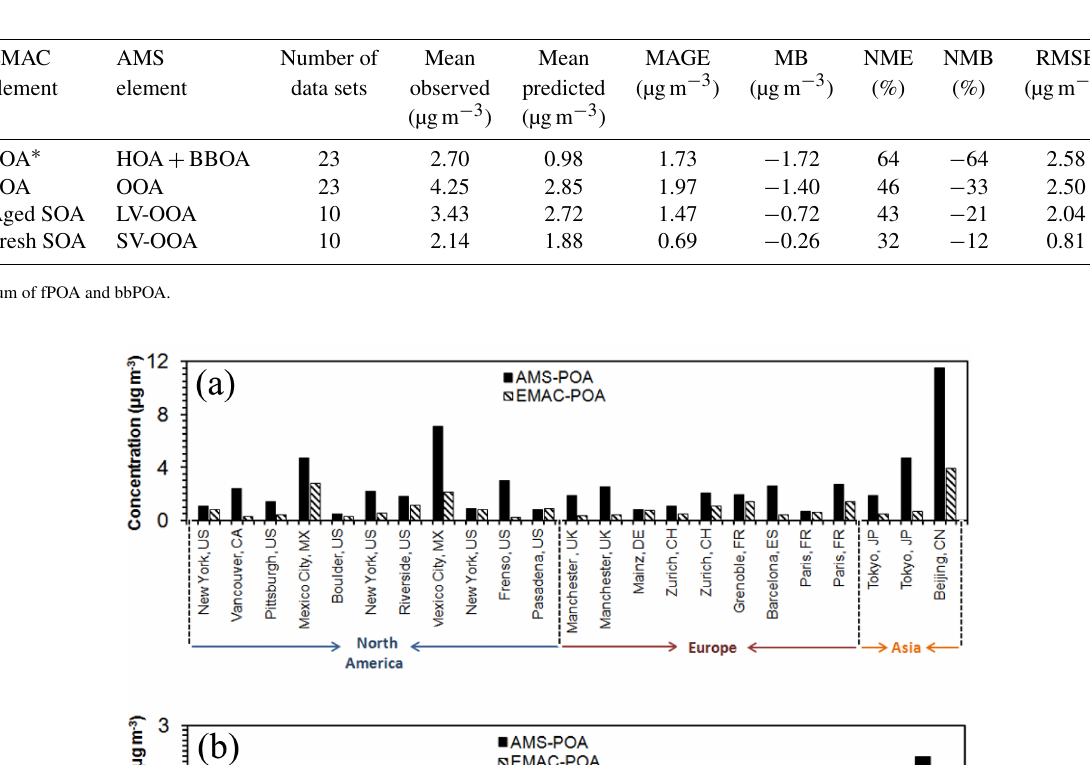
Table 2. Statistical evaluation of EMAC results against AMS measurements over urban locations of the Northern Hemisphere during 2001– 2010.